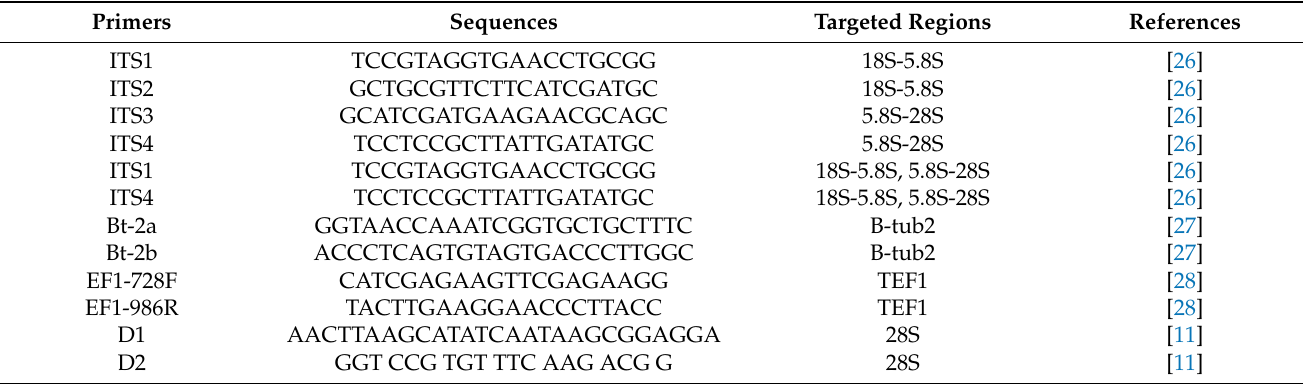
Table 1. Sets of primers used for amplifying the ITS, B-tub2, TEF1, and D1/D2 genetic regions.